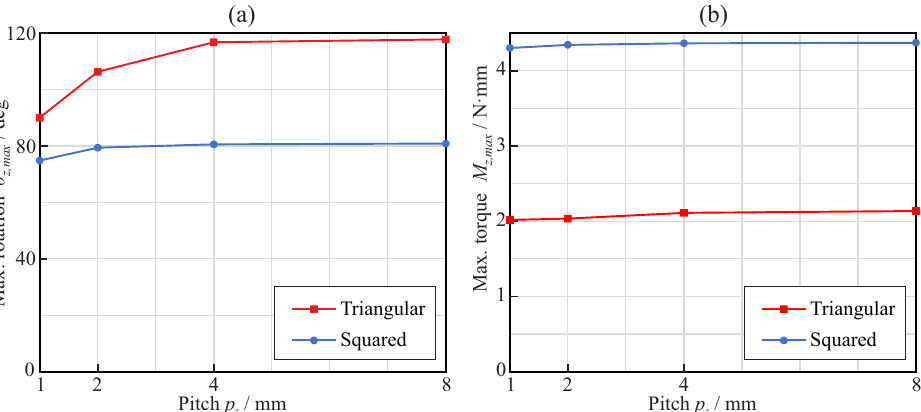
Figure 12. Torsional analysis: effect of the pitch on the applied torque ( a ) and rotation ( b ) when the end of the martensitic elastic regime is reached.